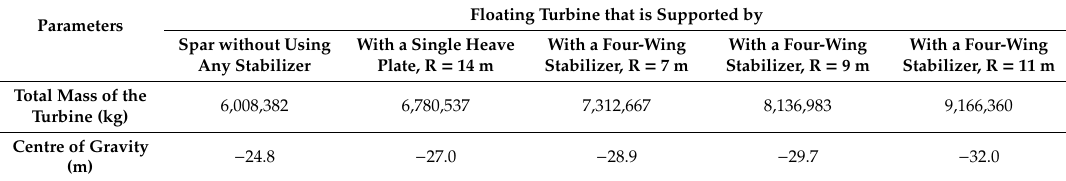
Table 4. The parameters of the floating turbine systems in di ff erent research Table 4 . The parameters of the floating turbine systems in different research scenarios.